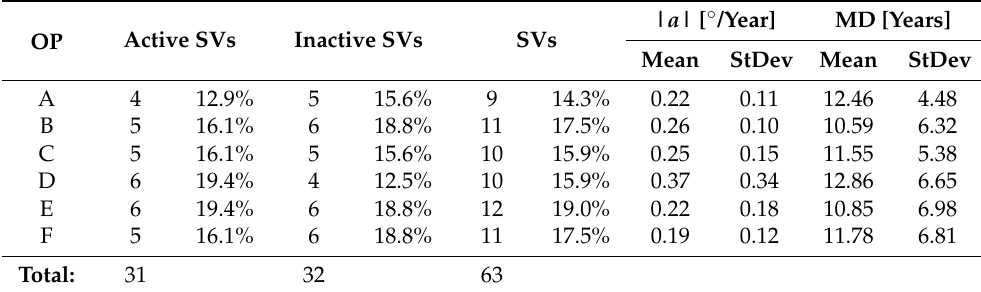
Table 5. Absolute value of the separation trend and mission duration (MD) of GPS satellites in